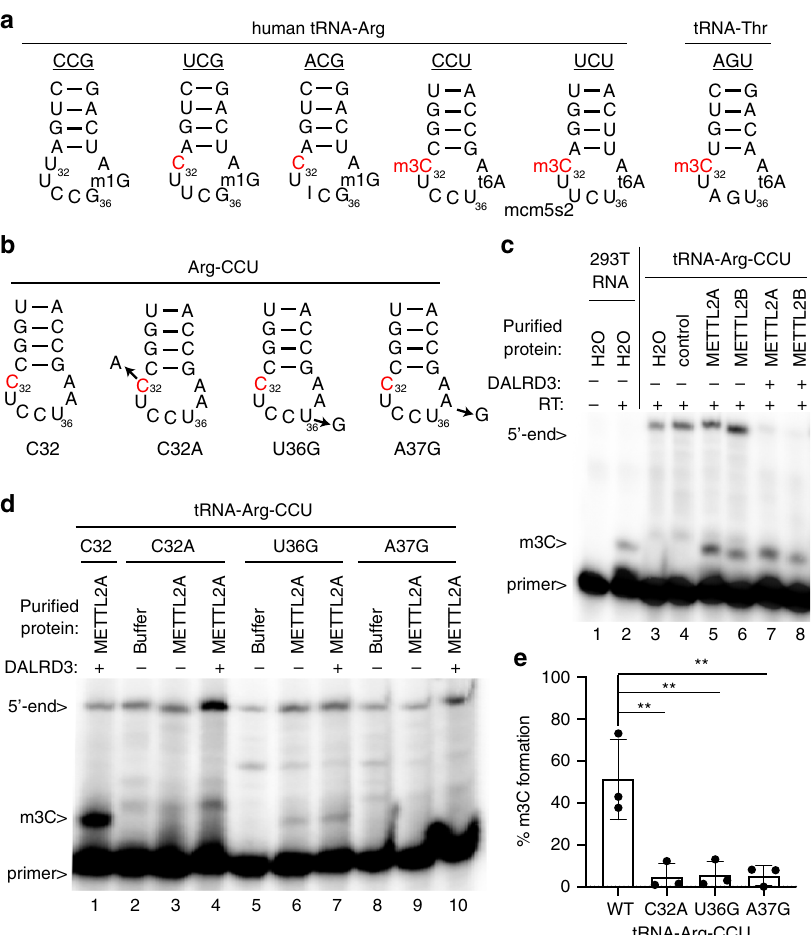
Fig. 4 The identity of residues 36 and 37 in tRNA-Arg-CCU play a key role in m3C formation by METTL2A/2B in vitro. a Anticodon loops of human tRNA-Arginine isoacceptors and known modi fi cations. b Anticodon loops of in vitro transcribed tRNA-Arg-CCU and variants used in c , d . c , d Primer extension analysis of tRNA-Arg-CCU and variants incubated with either water, vector control eluate, puri fi ed METTL2A or METTL2B co-expressed with DALRD3. Primer length, 23 nt. e Quanti fi cation of m3C formation in d . Primer extension analysis was performed greater than three times for c and repeated three times for d . Bars represent the standard deviation from the mean. Statistical analysis was performed using one-way ANOVA and signi fi